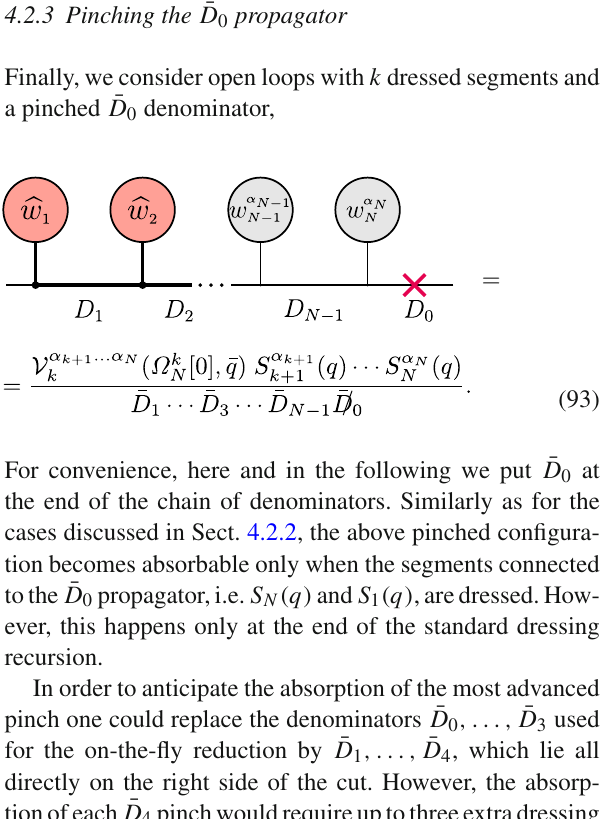
urations are stable with respect to further reduction